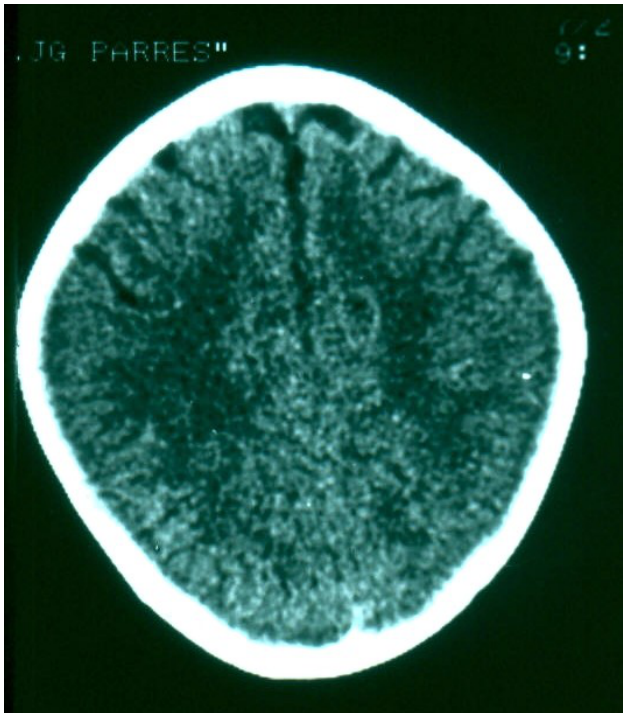
Figure 2: Computerized Axial Tomography (CAT) image of a mild cerebral edema in a child with severe scorpion